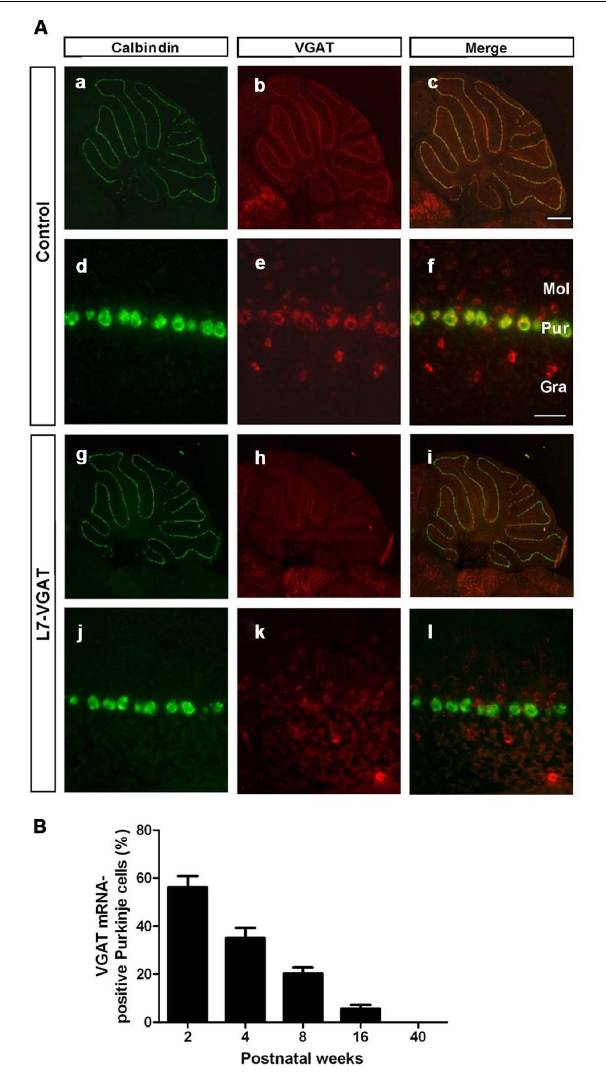
FIGURE 2 | Disappearance of VGAT mRNA specifically in the Purkinje cells of L7-VGAT mice. (A) Double in situ hybridizations for calbindin D-28K (a,d,g,j; green) and VGAT (b,e,h,k; red) were performed in parasagittal sections of 40-week-old mice.The cerebella of control (a–f) and L7-VGAT (g–l) mice are shown. (a–c) and (g–i) show images of the whole cerebella. (d–f) and (j–l) show images of lobule III. Merged images of (a,d,g,j) and (b,e,h,k) are shown in (c,f,i,l). Bars represent 500 μ m (c) and 50 μ m (f). (B) The percentage of VGAT mRNA-positive Purkinje cells (PCs) in the L7-VGAT mice at 2, 4, 8, 16, and 40 weeks postnatal.The number of VGAT mRNA-positive Purkinje cells was divided by the total number of calbindin mRNA-positive PCs in lobule III (L7-VGAT, n = 2; control, n = 2 of each age). The total numbers of calbindin-positive cells in the L7-VGAT mice that were counted were 230 at 2 weeks postnatal (P2W), 264 at P4W, 243 at P8W, 232 at P16W, and 200 at P40W. Each value represents the mean ± SEM. Gra, granule cell layer; Pur, Purkinje cell layer; and Mol, molecular layer.